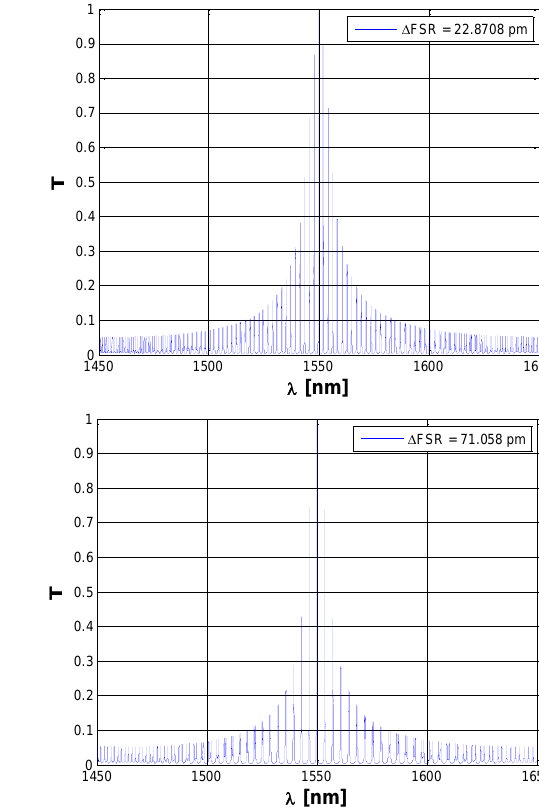
Figure 7. Vernier spectra of the sensor at rest calculated as a function of increasing values of